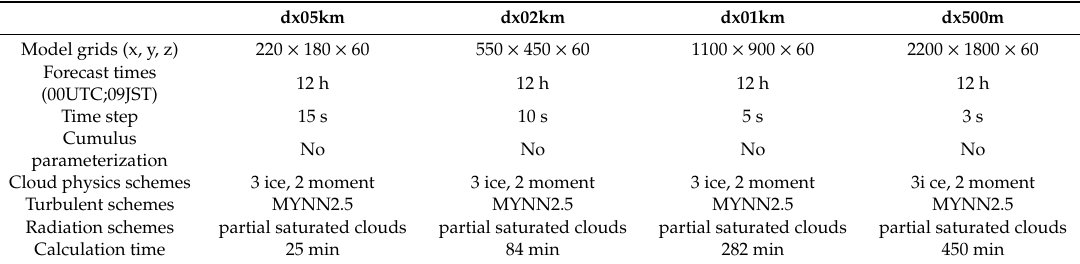
Table 1. Model set-up for numerical experiments with four di ff erent horizontal resolutions (dx05km, dx02km, dx01km, and dx500m). dx05km dx02km dx01km dx500m Model grids (x, y, z) 220 × 180 ×